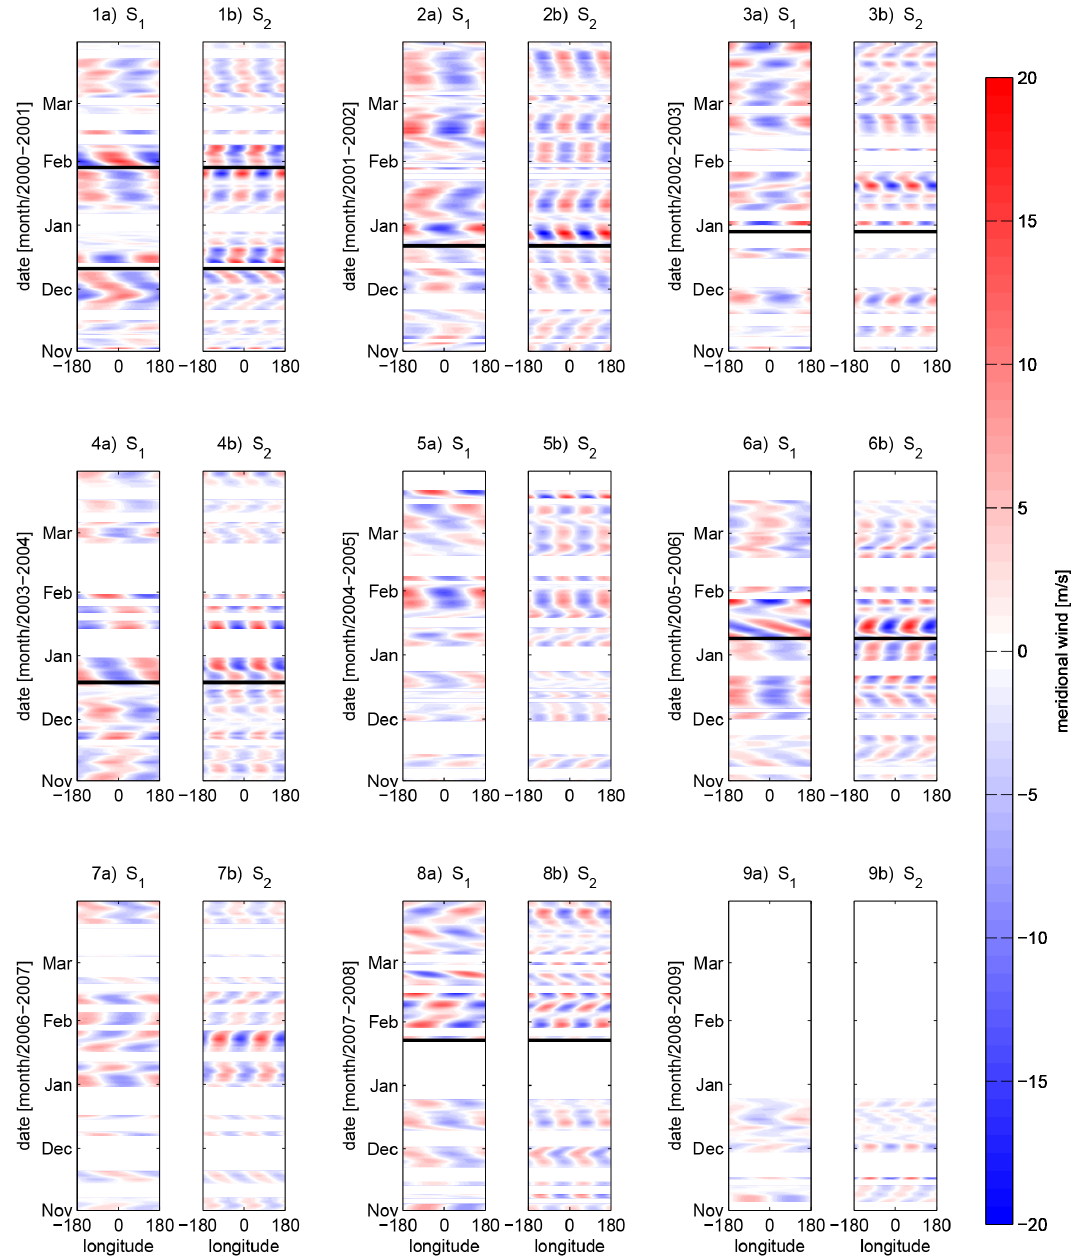
Figure 1. Longitudinal wave components S 1 (a) and S 2 (b) of the mean meridional wind anomalies for winters 2000/2001–2008/2009 (1–9). Red and blue colors signify poleward and equatorward wind, respectively. The horizontal black lines indicate the onset of the wind reversal for each of the SSW events that were accompanied by an elevated stratopause (see Sect.